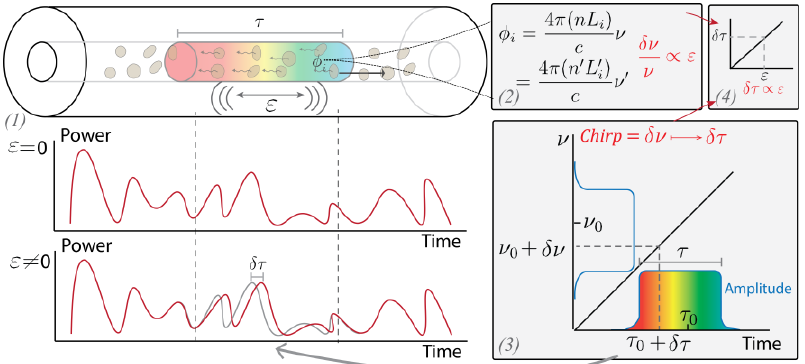
Figure 1. (From Ref. [12]) Working principle of chirped-pulse Φ OTDR: ( 1 ) A linearly chirped optical pulse propagates along the fibre, and a small fraction of the power is elastically backscattered. ( 2 ) The optical trace from the interference of the backscattered light will vary if a perturbation over the fibre locally altering the optical path distance (i.e., changes to the refractive index n or length L i ) occurs. A frequency detuning may compensate for the change in phase, thus recovering the previous optical trace. ( 3 ) The pulse linear chirp maps this frequency detuning into a temporal delay within the pulse window, in such a way that the optical trace contains a local time delay proportional to the perturbation, @2019 IEEE [12].